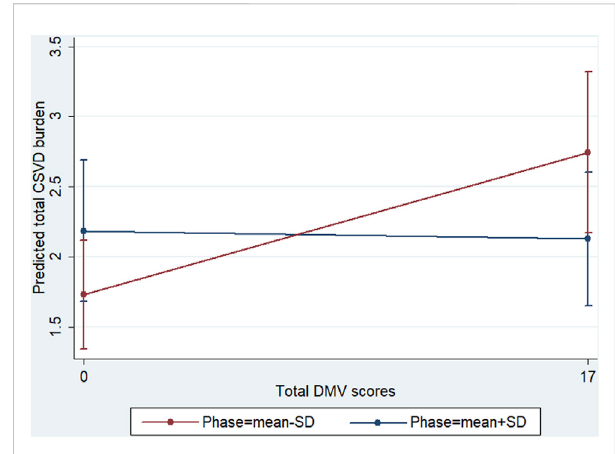
FIGURE 4 Interactiondiagram.PredictivemarginalmeansofthetotalCSVD burden with total DMV scores and phase strati fi ed at the lower (mean − SD) and higher (mean +SD) phases. The con fi dence intervals of the margins of the total CSVD burden overlapped when the higher phase was compared across the total DMV scores. When